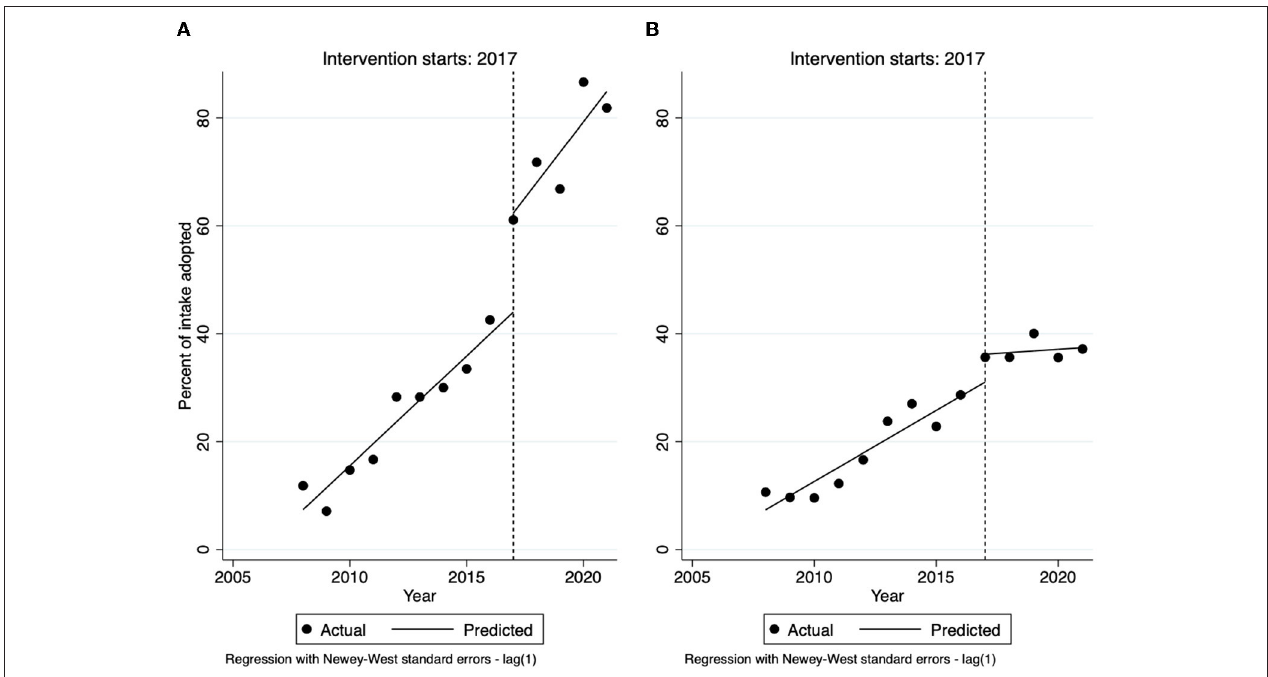
FIGURE 5 | Interrupted time series analysis of the percent of intake of cats (A) and dogs (B) with an outcome of adoption. Line at intervention year (2017).